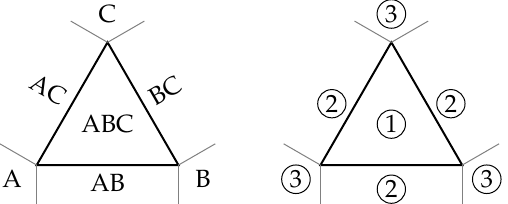
Figure 4. Spatial lookup for nearest-projection mapping: The selection zones of the cascading algorithm used by the nearest-projection onto a single triangle ABC. If the location of the orthogonal projection of the original data point is outside of ABC, the projection onto edges are considered before finally projecting onto vertices. The image on the right describes the order in which the zones are